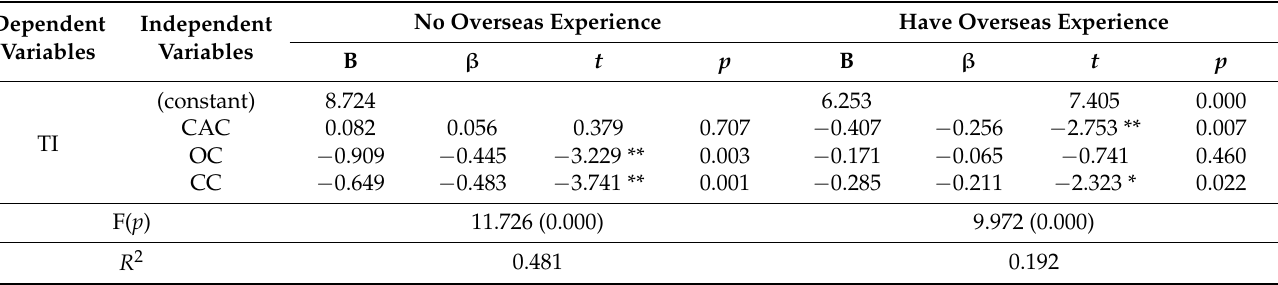
Table 5. Moderating effect of overseas